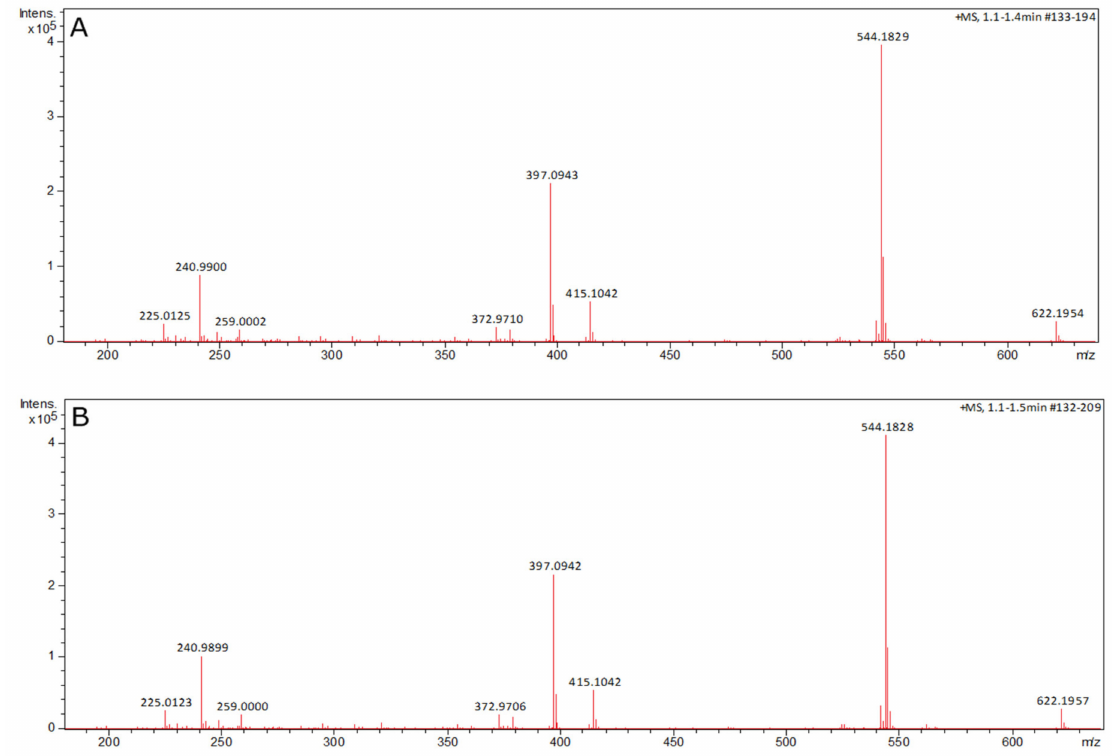
Figure 4. Mass spectrometry spectra of doxorubicin ( A ) and after application of 8 electric pulses, duration of 100 µ s, 1000 V / cm each ( B ).